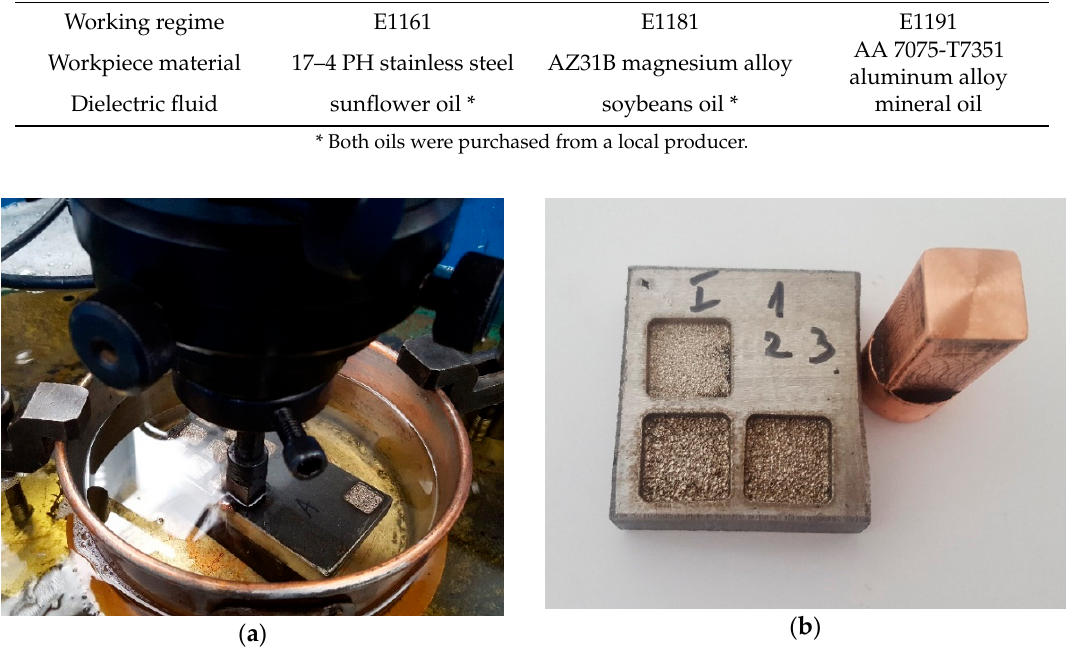
Table 3. Specific parameters of the working regimes [24]. Working Regime